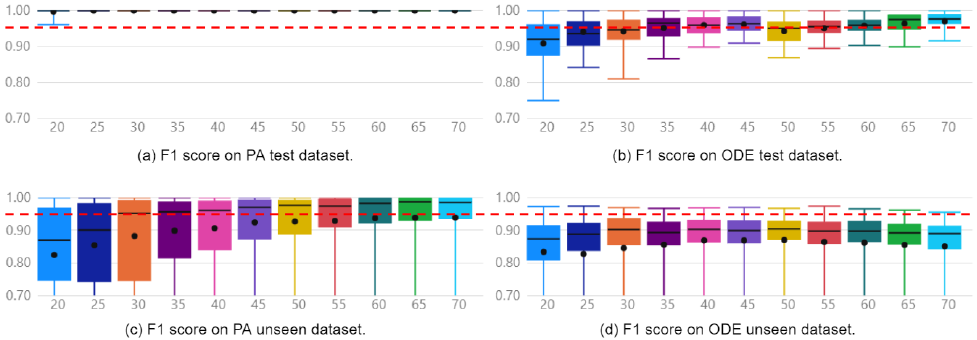
Figure 9. F1 Score of Furnace classifiers by number of instances for training, over: ( a ) PA test data, ( b ) ODE test data, ( c ) PA unseen data, ( d ) ODE unseen